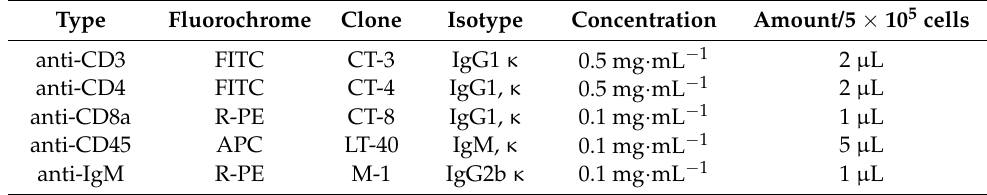
Table 3. Specification and amounts of used mouse anti-chicken monoclonal